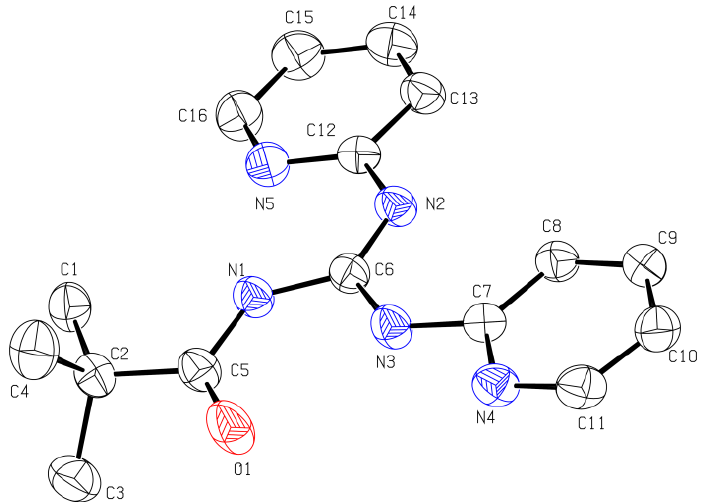
Figure 2. ORTEP diagram of N -pivaloyl- N ′ , N ′′ -dipyridylguanidine ( 11 ). Thermal ellipsoids are shown at the 50% probability level. Hydrogen atoms are omitted for clarity.